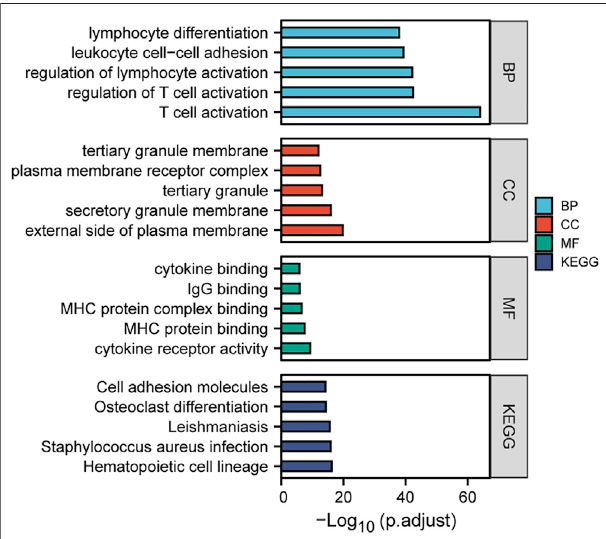
FIGURE 7 | Gene Ontology (GO) and Kyoto Encyclopedia of Genes and Genomes (KEGG) enrichmentanalyses of the TRPM2-related genes in kidney renal clear cell carcinoma (KIRC). Gene expression was calculated using Pearson ’ s correlation analysis based on KIRC RNA-seq data from The Cancer Genome Atlas (TCGA), and then the TRPM2-related genes (| r | > 0.5 and p < 0.05)inKIRCweresubjectedtoGOclassi fi cationandKEGGpathway enrichment analysis